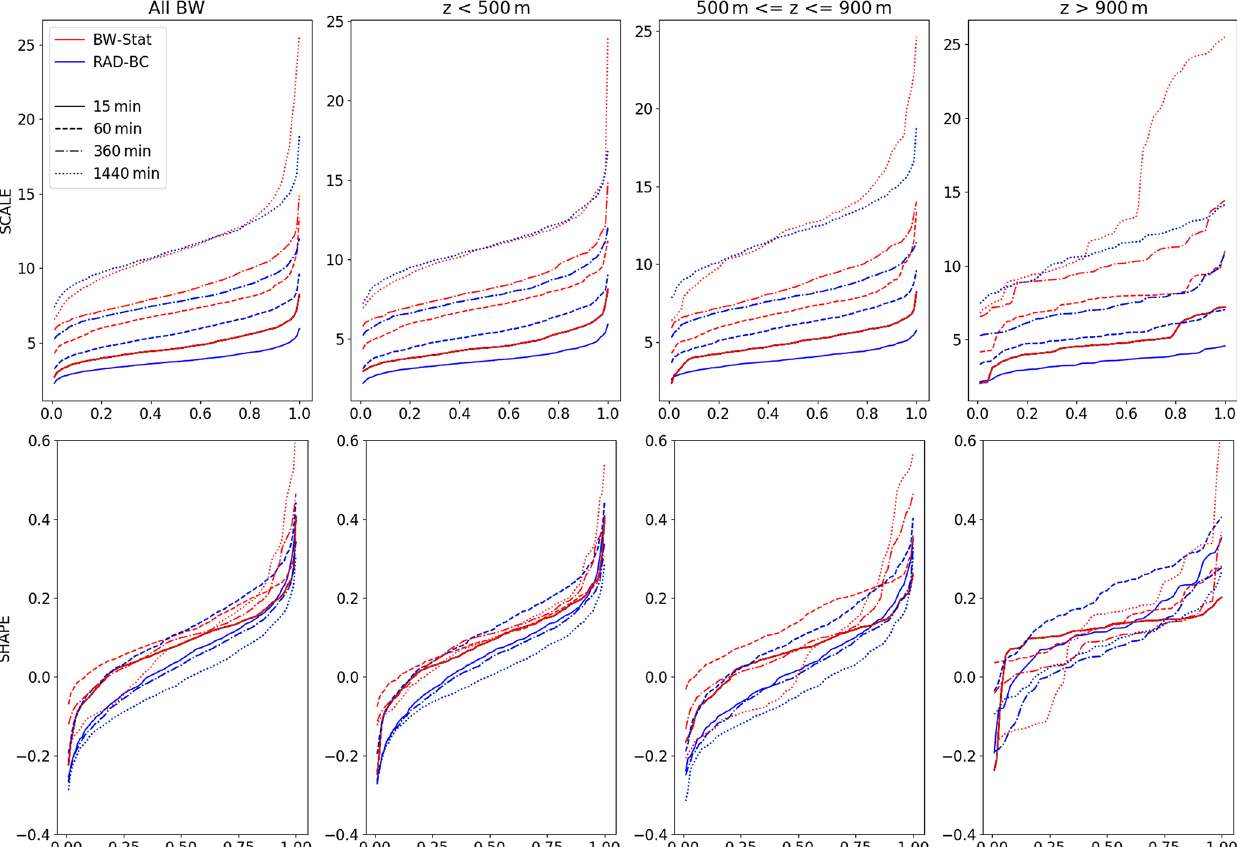
Figure 7. Spatial cumulative frequency distributions (CFDs) of the scale (upper row) and shape (bottom row) parameter for the BW-Stat and RAD-BC datasets, when comparing stations and radar data at the location of all stations (left column) and for three different subsets filtered by the altitude of the respective station